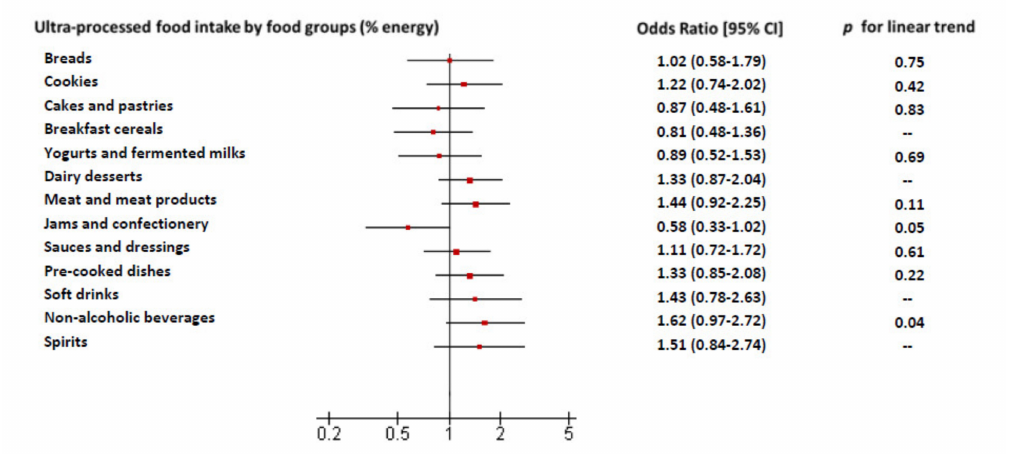
Figure 2. Odds ratio of abdominal obesity risk and 95% confidence intervals (95% CIs) for tertile (highest intake) of groups of ultra-processed food consumption as a percentage of total energy (% of energy) versus Tertile 1 (lowest intake), in the Seniors-ENRICA 1 cohort study. n = 652. When the intake of ultra-processed food from a specific food group occurred in less 25% of the participants, the odds ratio (95% CI) was calculated between subjects who consumed the food compared to those who did not (as in breakfast cereals, dairy desserts, soft drinks and spirits). p for linear trend was calculating using tertiles as a continuous variable. Model was adjusted for sex, age, level of education, marital status, tobacco consumption, ex-drinker status, physical activity at household, physical activity at leisure time, number of medications used, number of chronic diseases (respiratory disease, coronary disease, stroke, osteoarthritis / arthritis and depression), fiber intake, long-chain ω -3 fatty acids intake and Mediterranean diet adherence. Other non-alcoholic beverages group includes instant co ff ee drinks